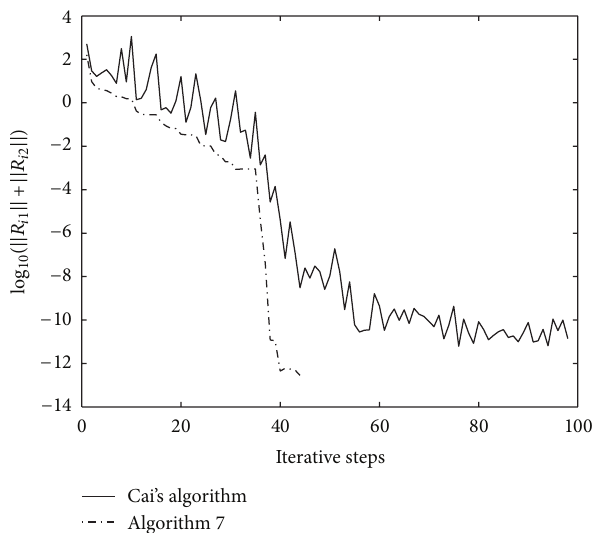
Figure 2: Convergence curves of log 10 (‖𝑅 𝑖1 ‖ + ‖𝑅 𝑖2 ‖)